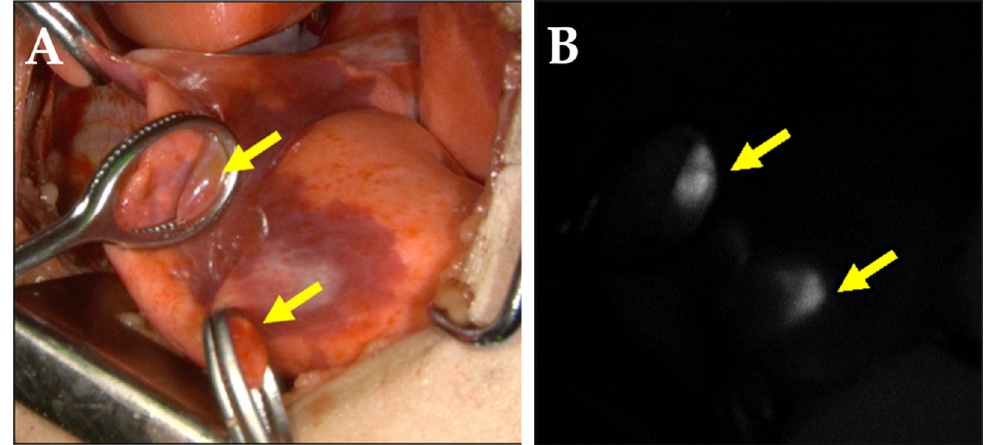
Figure 3. Metastatic lung lesions. ( A ) Visible ray photograph demonstrating the intraoperative lung surface. Yellow arrows indicate lung metastases. ( B ) Photograph demonstrating the lung metastases of the lesions shown in ( A ) using fluorescence.